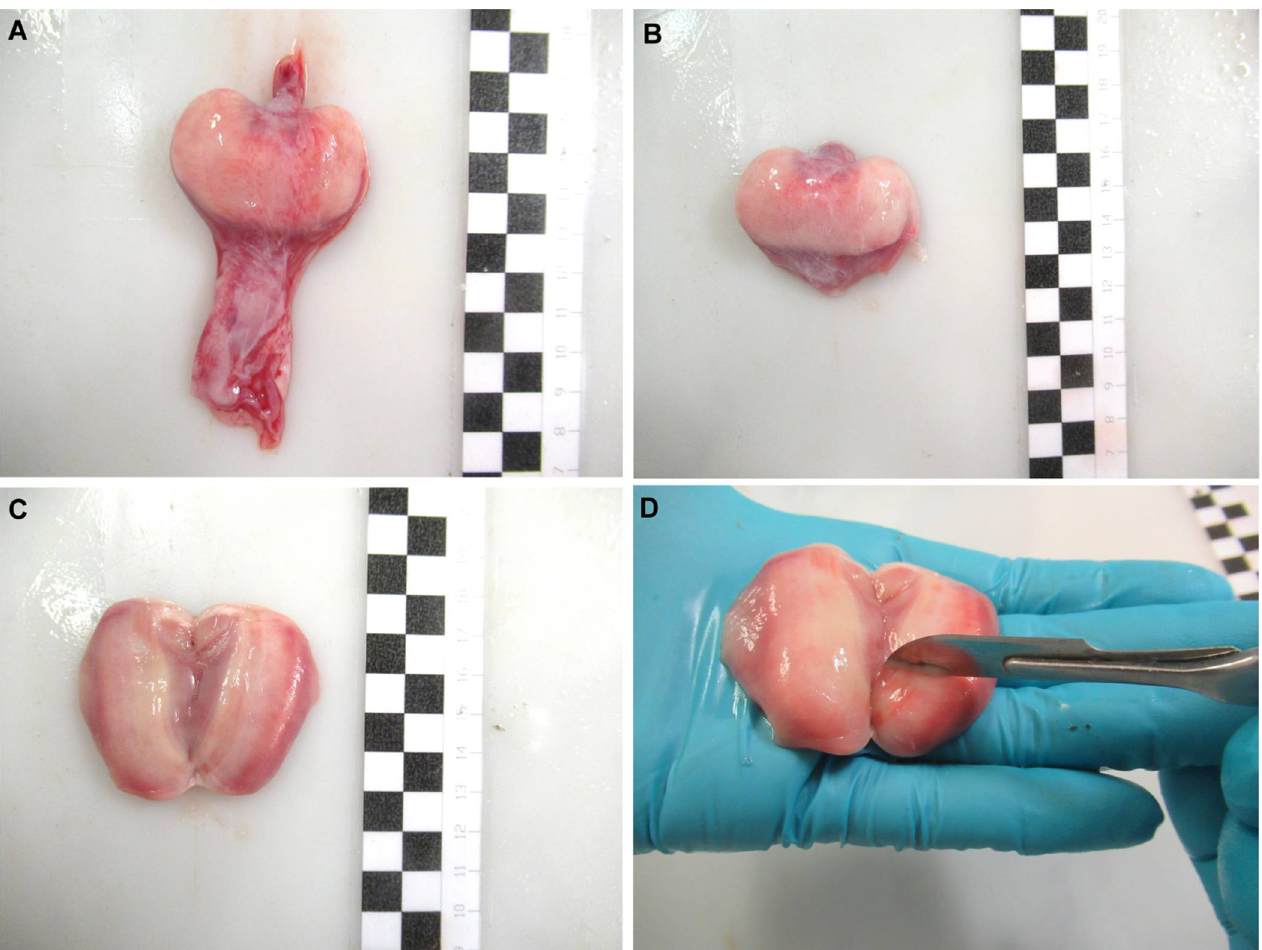
Figure 2. Sperm recovery from the oviducal gland. Oviducal gland from longnosed skate Dipturus oxyrinchus ( A ) removed from the oviduct. The gland was cleaned ( B) and split through its longitudinal axis, exposing its lumen ( C ). A scraping was done over its luminal epithelium using the blunt edge of a scalpel ( D ) to collect a pearly mucus containing sperm. Each black and white square of the scale bar indicates 1 cm.